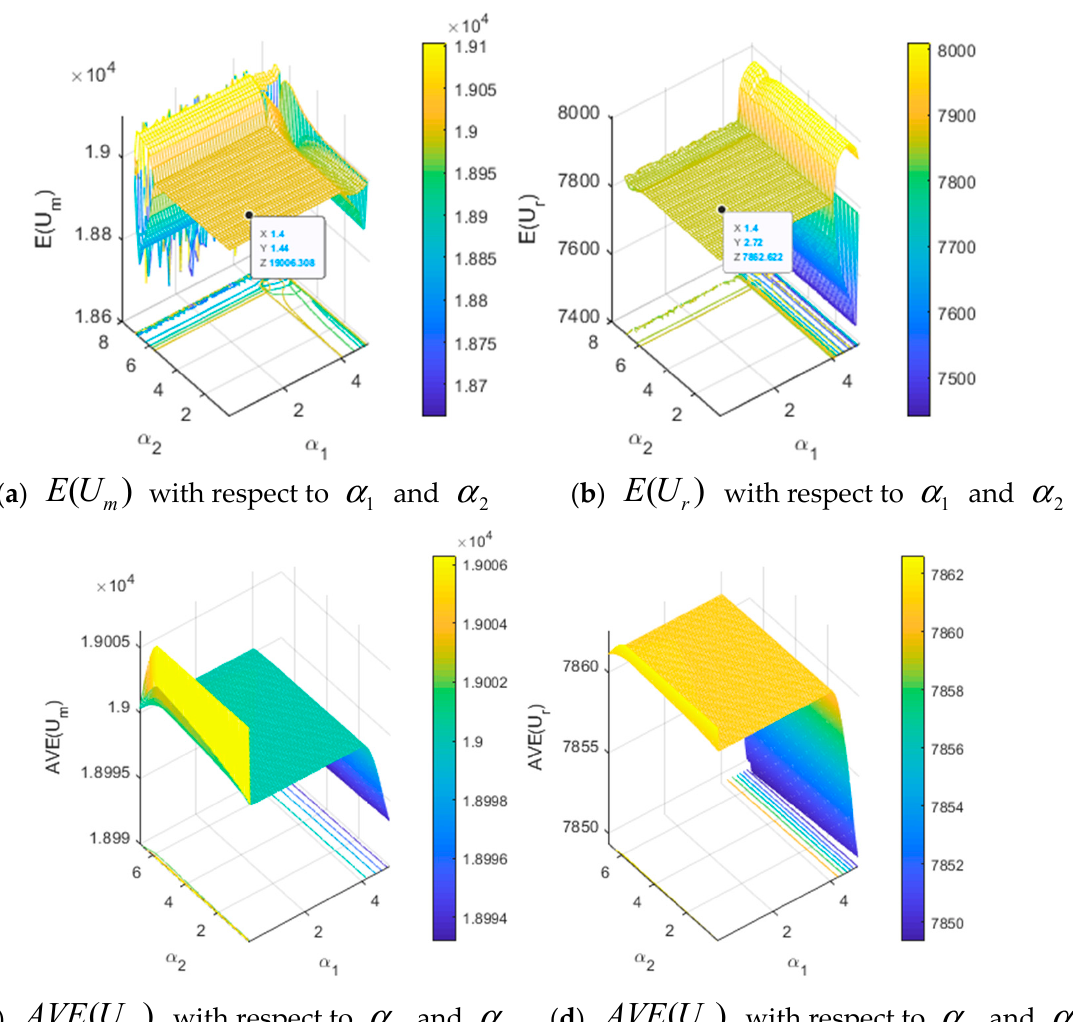
α α and . Figure 7. The expected utilities and the average expected utilities with respect to α 1 and α 2 1 2